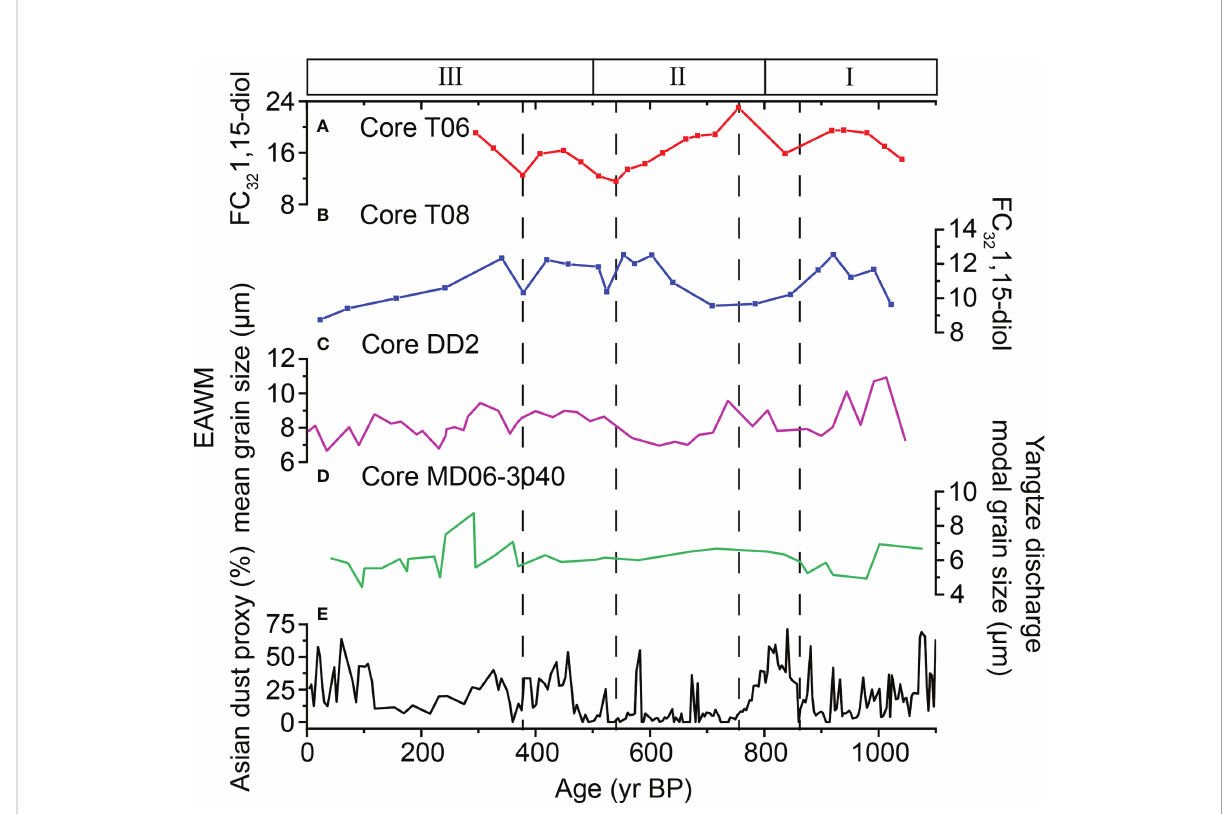
FIGURE 4 Records of FC 32 1,15-diol proxy in cores T06 and T08 and other environmental parameters over the past 1000 years: (A) FC 32 1,15-diol proxy in core T06; (B) FC 32 1,15-diol proxy in core T08; (C) EAWM strength, as reconstructed from average particle size in the<45 µm size fraction in core DD2 (Xiao et al., 2004); (D) Yangtze River discharge, as inferred from the modal grain size of the fi ne silt fraction from core MD06-3040 (Wang et al., 2014); and (E) changes in Asian dust activity, as inferred from Lake Gonghai, northern China (Chen et al., 2020). The black dashed line indicates that the main phases of increased FC 32 1,15-diol values at T06 correspond well to increases in Asian dust